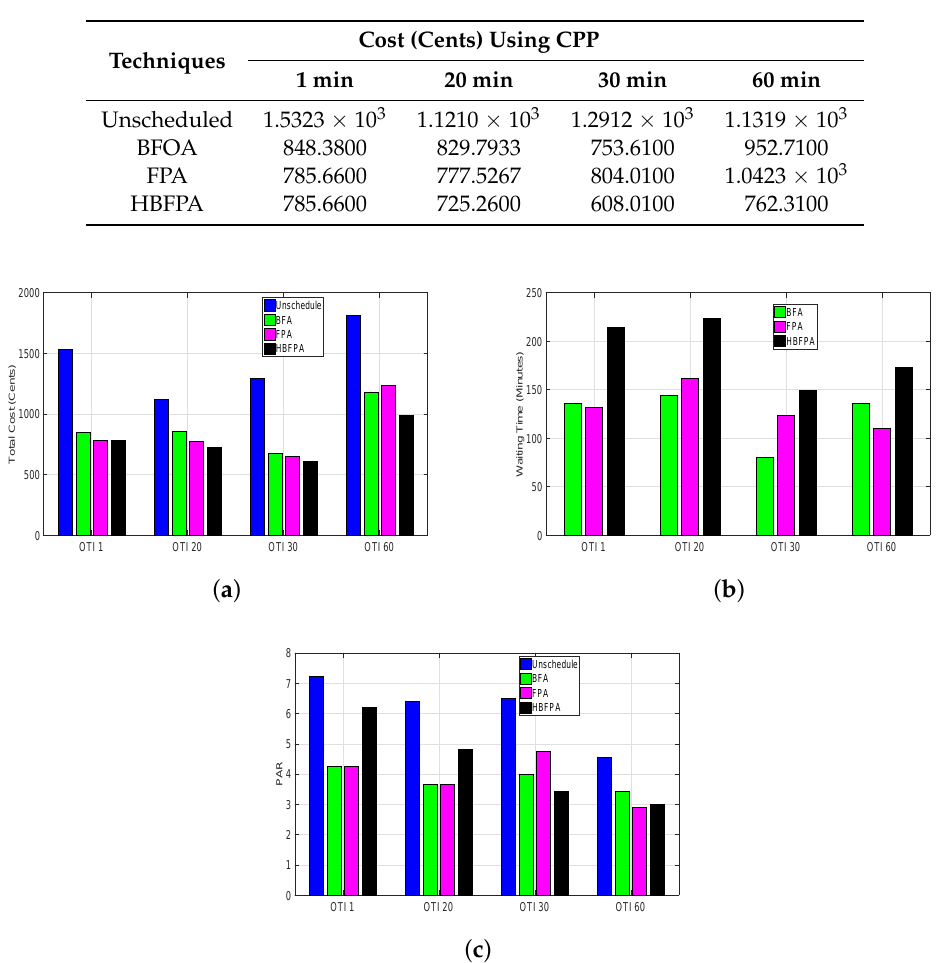
Figure 6. Total cost, waiting time and peak to average ratio for a single home using critical peak